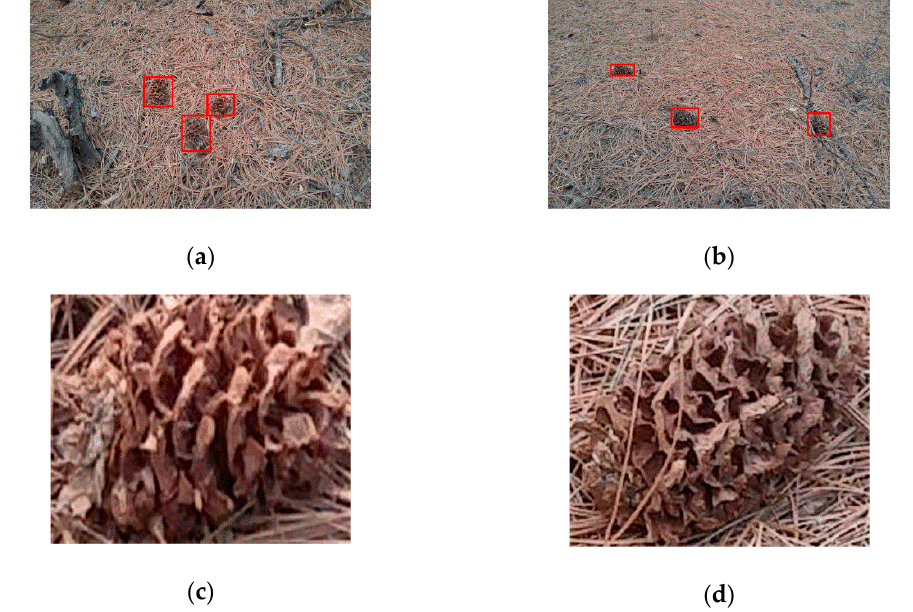
Figure 10. Original data image. ( a , b ) Complete data images; ( c , d ) pine cone samples.